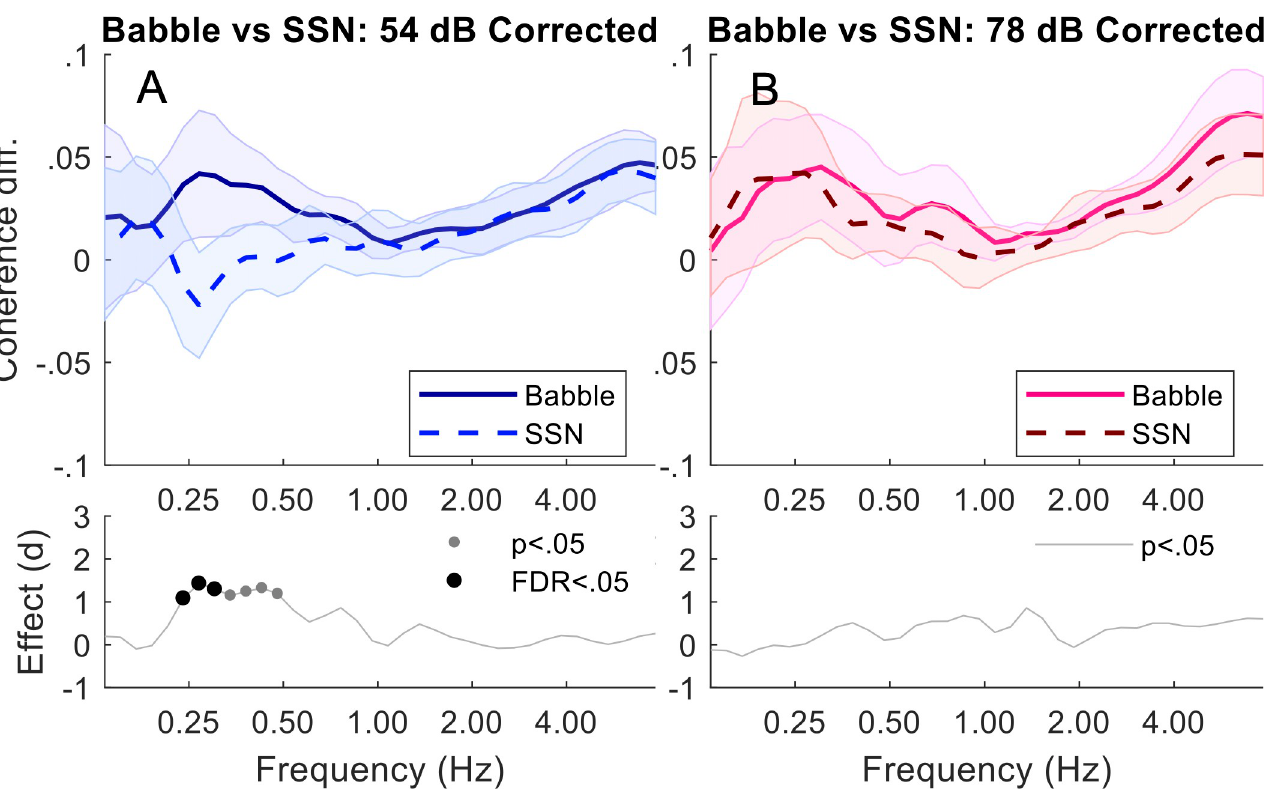
Fig 5. Triads in speech-shaped noise vs babble. Top plots of (A) and (B) show corrected (baseline removed) coherence responses comparing SSN vs Babble conditions for 54 and 78 dB. Cohen’s d effect sizes, with corresponding significance points (if any), are shown in the lower plots.